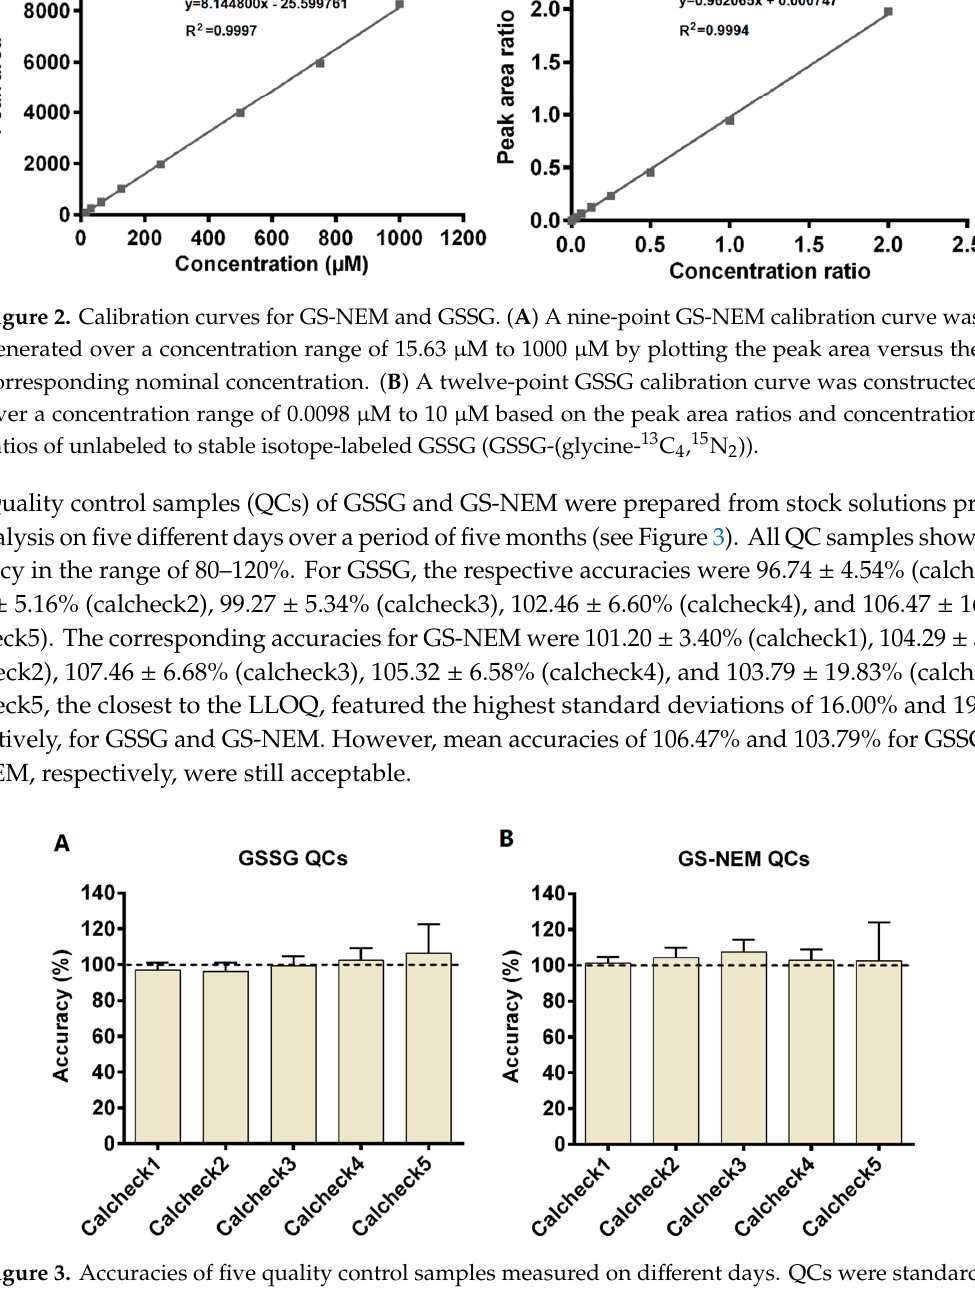
Figure 3. Accuracies of five quality control samples measured on different days. QCs were standard